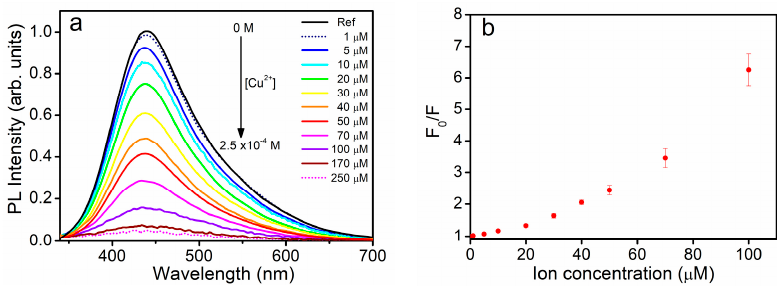
Figure 3. ( a ) Emission spectra of the reference aqueous suspension of UFQDs in the presence of Cu 2+ at different concentrations. ( b ) Stern-Volmer plot describes the fluorescence quenching intensity vs. the Cu 2+ concentration over the range 0–100 μ M.